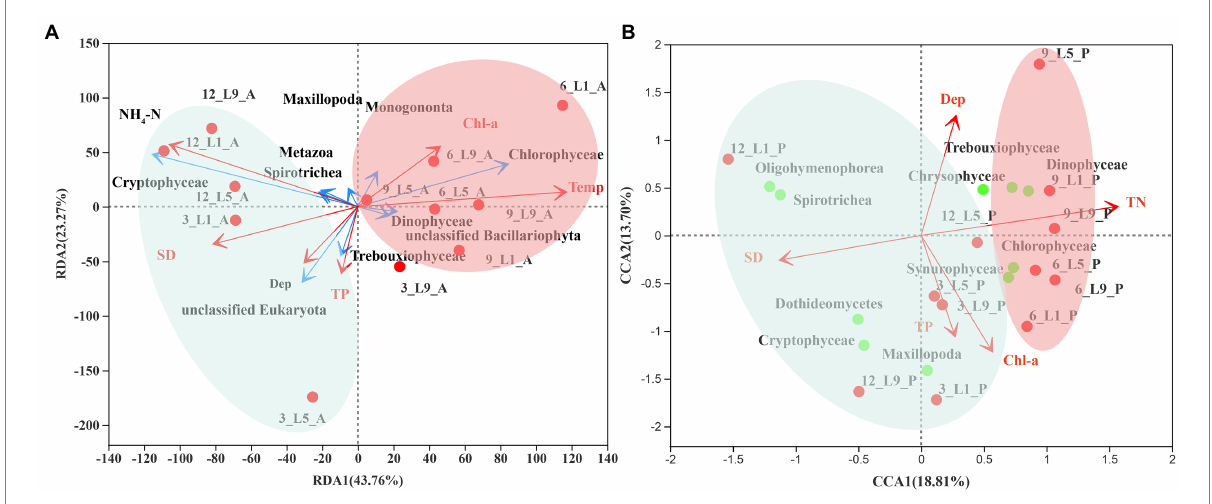
FIGURE 6 Restrictive ordination analysis of relationship between eukaryotic communities and environmental factors. (A) RDA of ambient water samples: Relative abundance of top 10 eukaryotes (blue arrows), environmental variables (red arrows). (B) CCA of Polyarthra samples: Relative abundance of top 10 eukaryotes. 12 and 3: December and March (cyan circle); 6 and 9: June and September (red